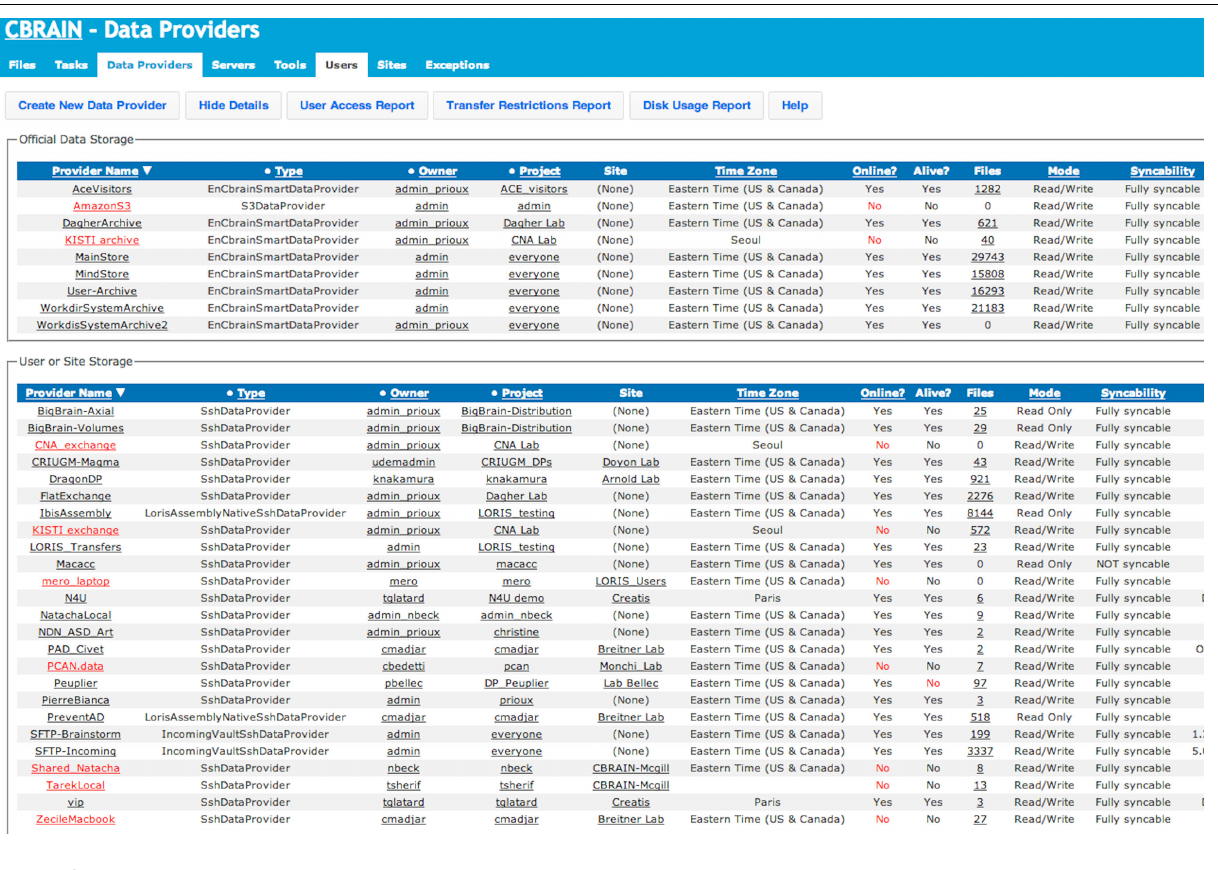
shown: type of connection, project, owner, time zone, number of registered files and/or file collections, read/write mode, and synchronization mode. Reports for group access, transfer restrictions, and disk usage are